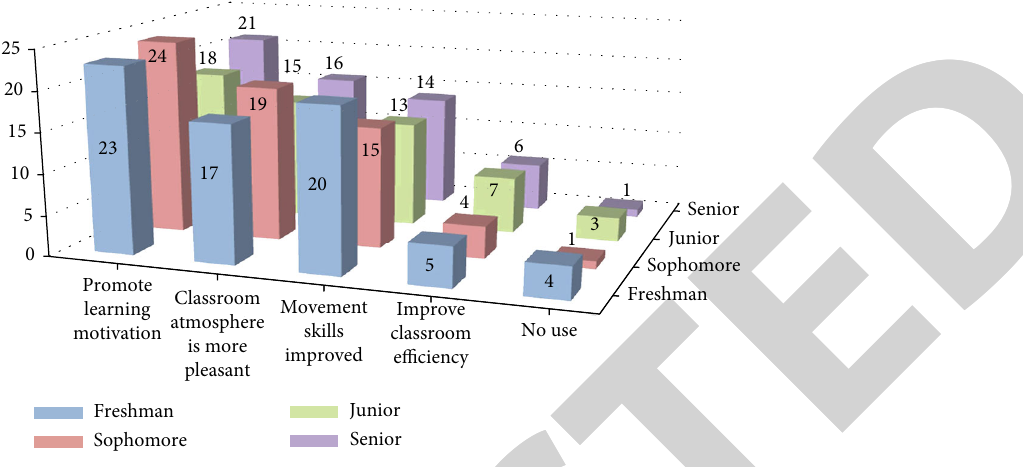
Figure 5: Students ’ views on the design of learning activities in smart sports classrooms. Table 6: Attitudes of college PET towards smart physical education.